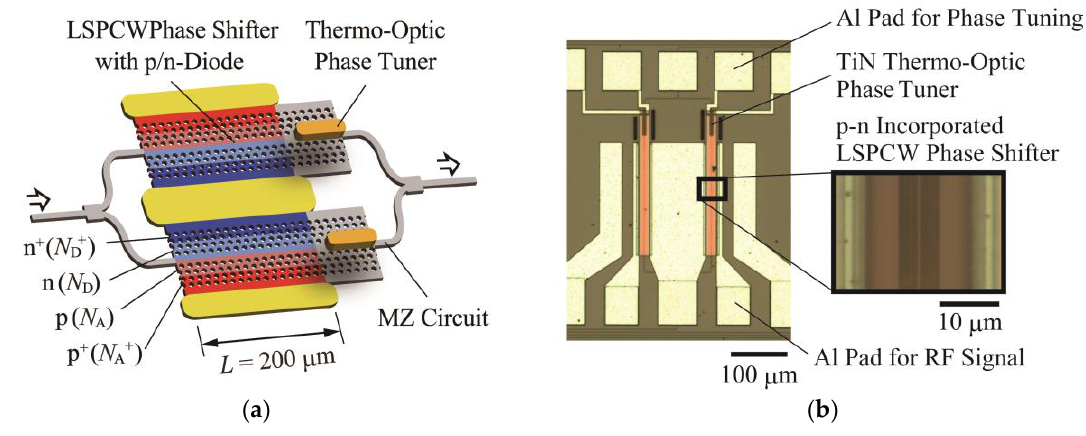
Figure 1. Si LSPCW MZ modulator. ( a ) Schematic. Interleaved p-n junction was employed but not shown in this figure; ( b ) Microscope image of fabricated device.